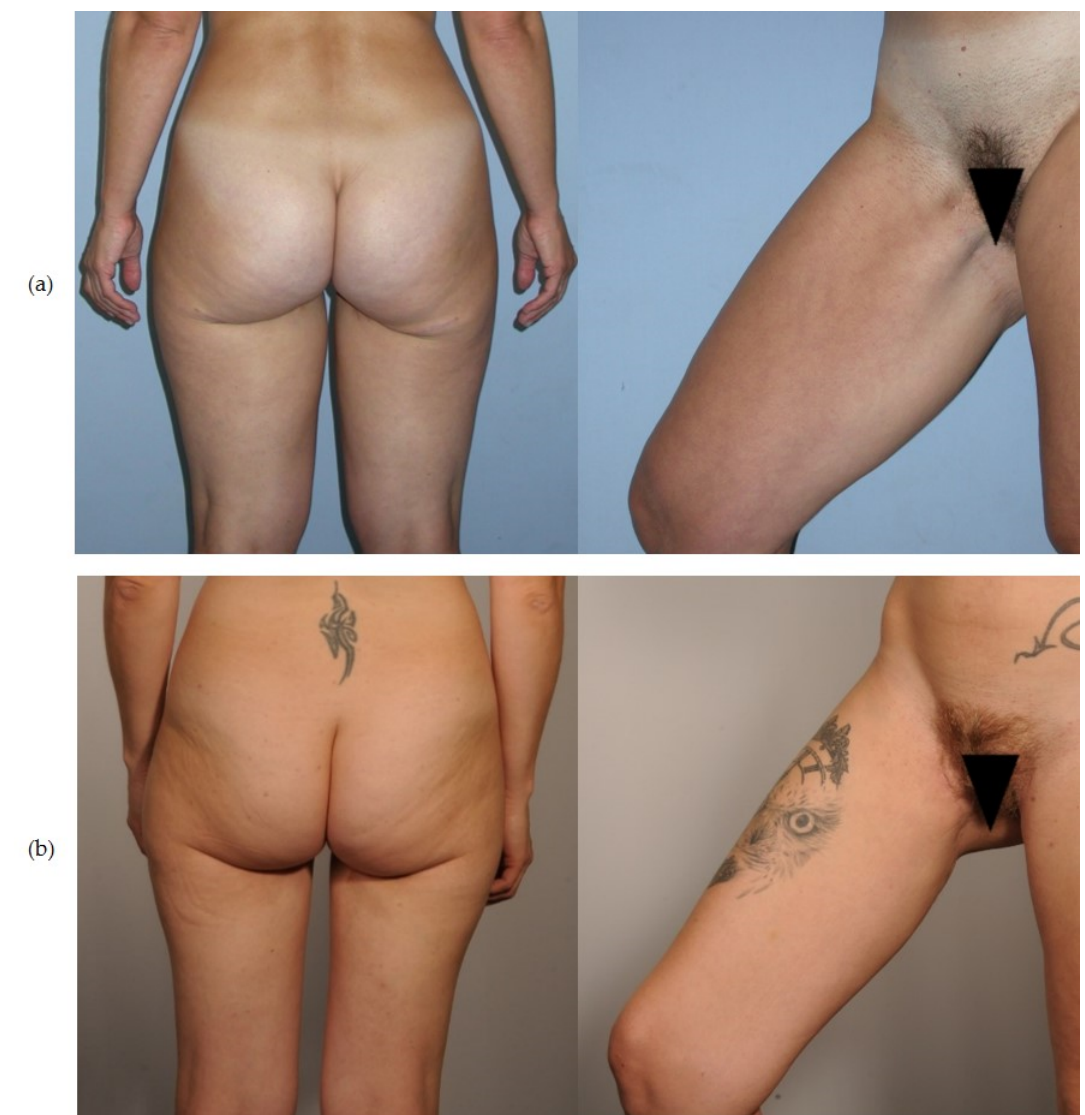
Figure 3. Cosmetic results. Post-operative views of donor-site after bilateral flap harvesting: ( a ) TMG flap and ( b ) PAP flap.